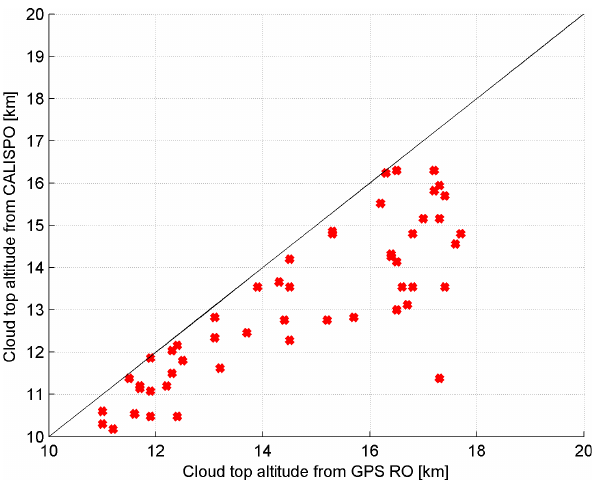
Fig. 6. Scatter plot between cloud top height from GPS ROs (as in Fig. 4) and the average cloud top height (averaged along the satellite orbit track) from CALIOP.